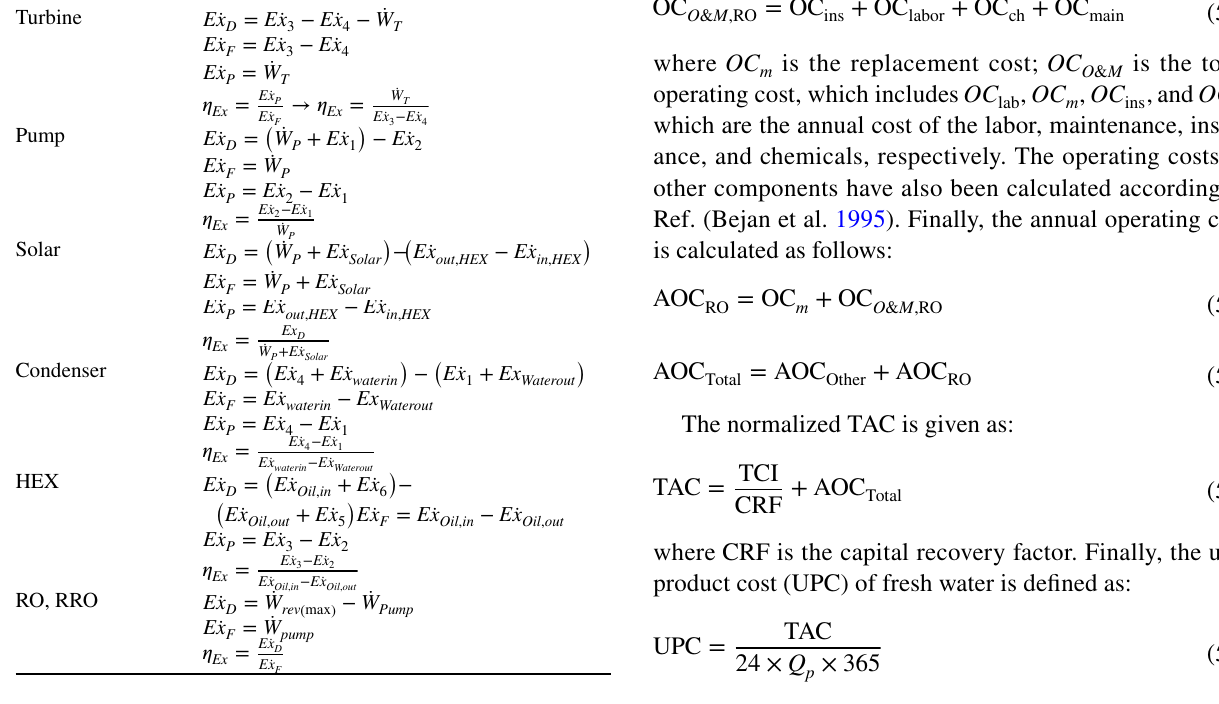
Table 4 Exergy balance equations and functions for equipment Component Exergy equation